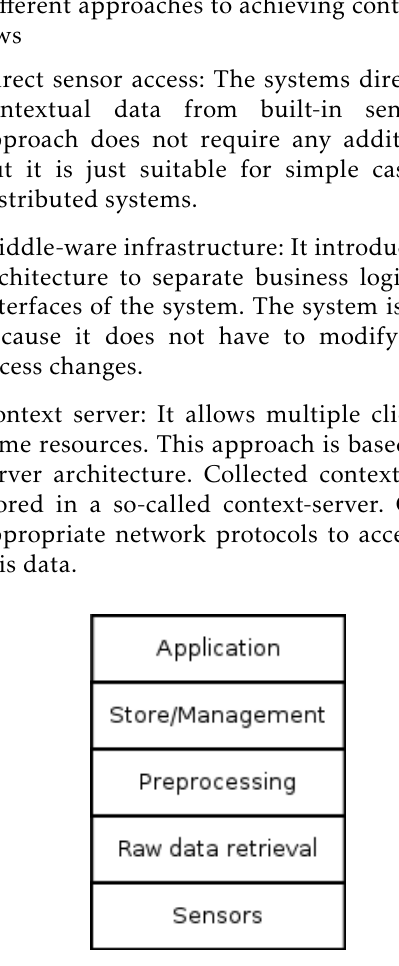
Figure 1. A layered conceptual framework for context-